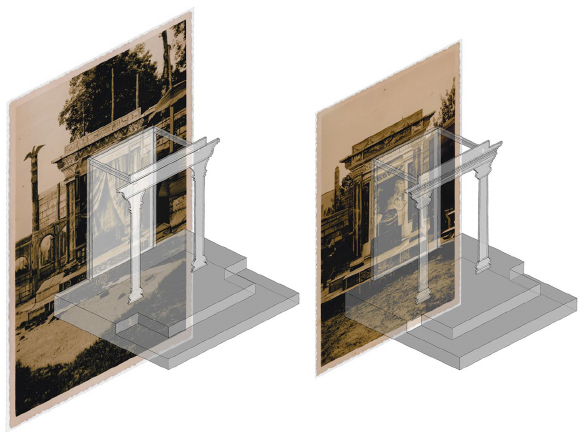
Figure 8 . Re-source based virtual reconstruction (1934’s historical photos) for Cattedra di Anna and Cattedra di Caifas .